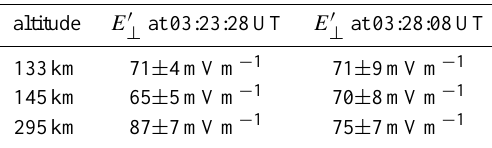
Table 1. Effective electric field vs. altitude for the ion temperature profiles of Fig.